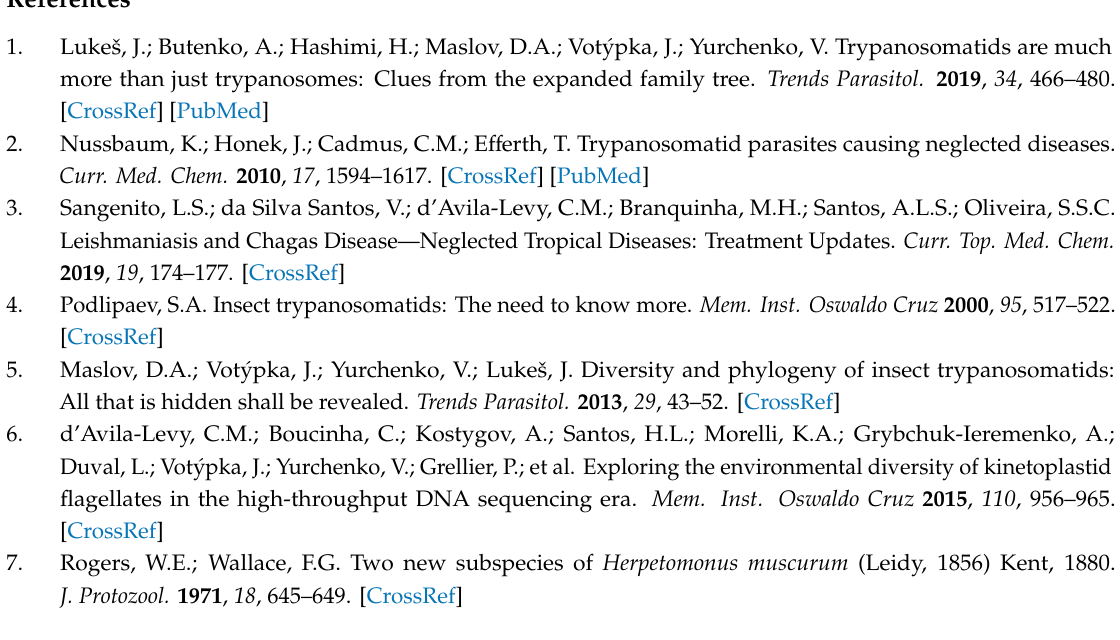
Table S1: Putative protein list based on the automated annotation by Companion, using Leishmania major as